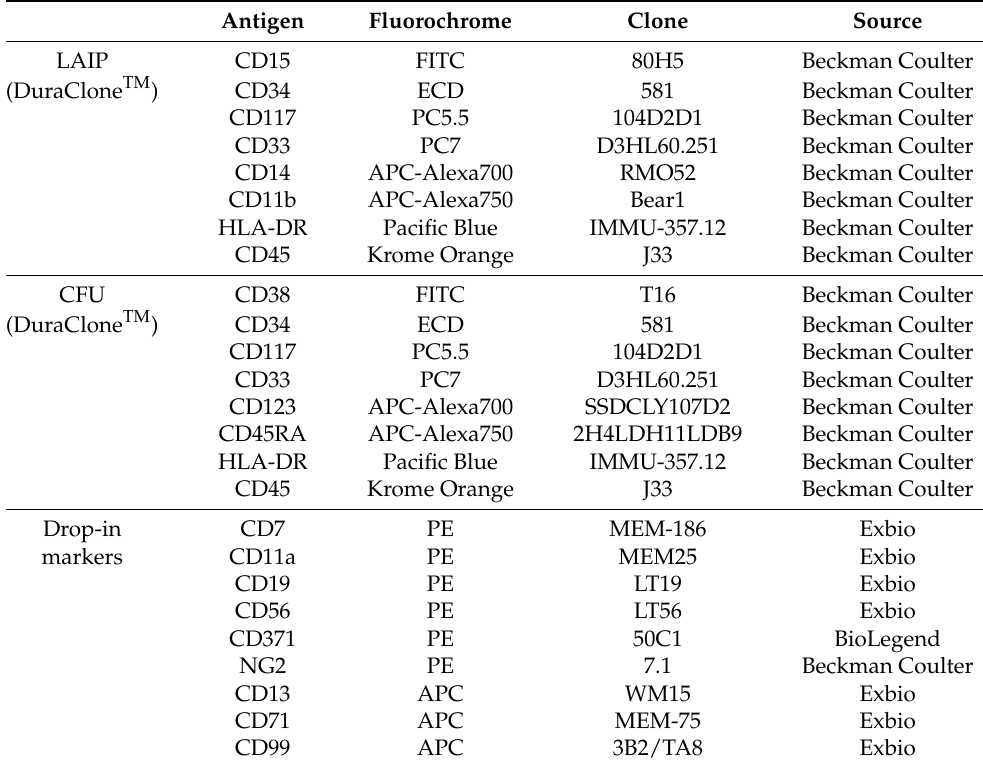
Table A1. Full details on antibodies used.